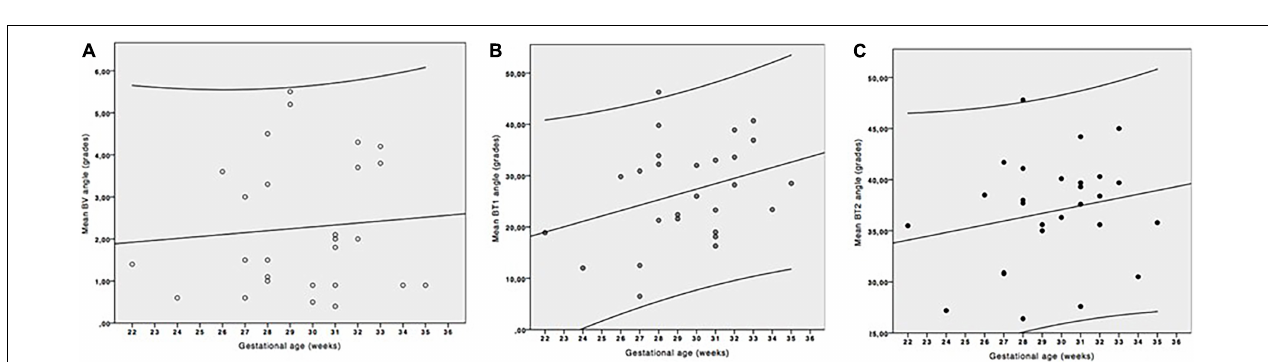
FIGURE 4 | Interobserver variation for BT1 and BT2 angles measurements. Bland-Altman plots for BT1 (A) and BT2 (B) angles. Continuous blue line represents the mean of the interobserver differences and the dashed lines represent the 95% confidence interval.